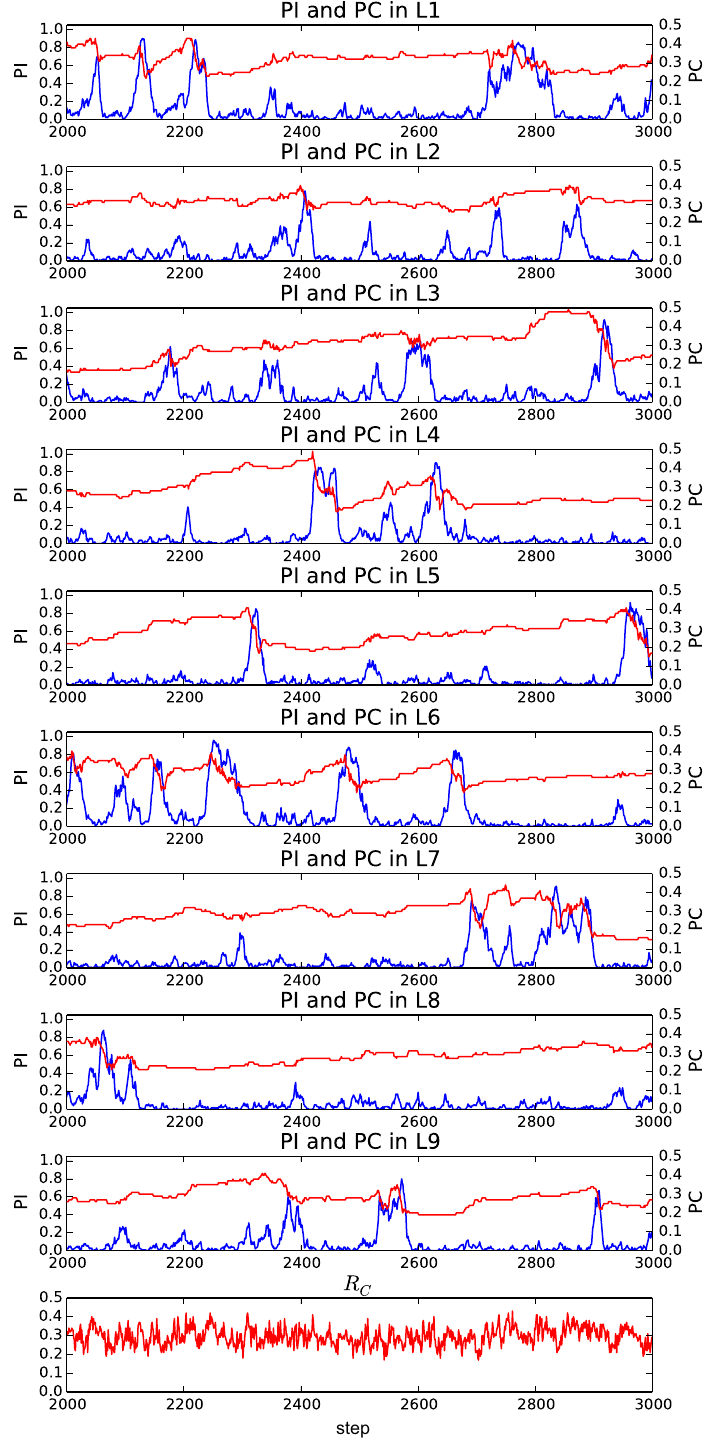
Figure 6. The transition of the proportion of cooperative behaviors ( red ) among the selected strategies ( PC ) and the proportion of individuals ( blue ) ( PI ( l ) ) in the layer l when M = 9. The bottom panel shows the proportion of cooperation among all of the selected layers ( PC ). The occurrence of a burst-like rise and fall of the proportion of individuals ( PI ( l ) ) in a layer was more pronounced, and it often reached its peak around 0.8, meaning that most of the individuals selected the same